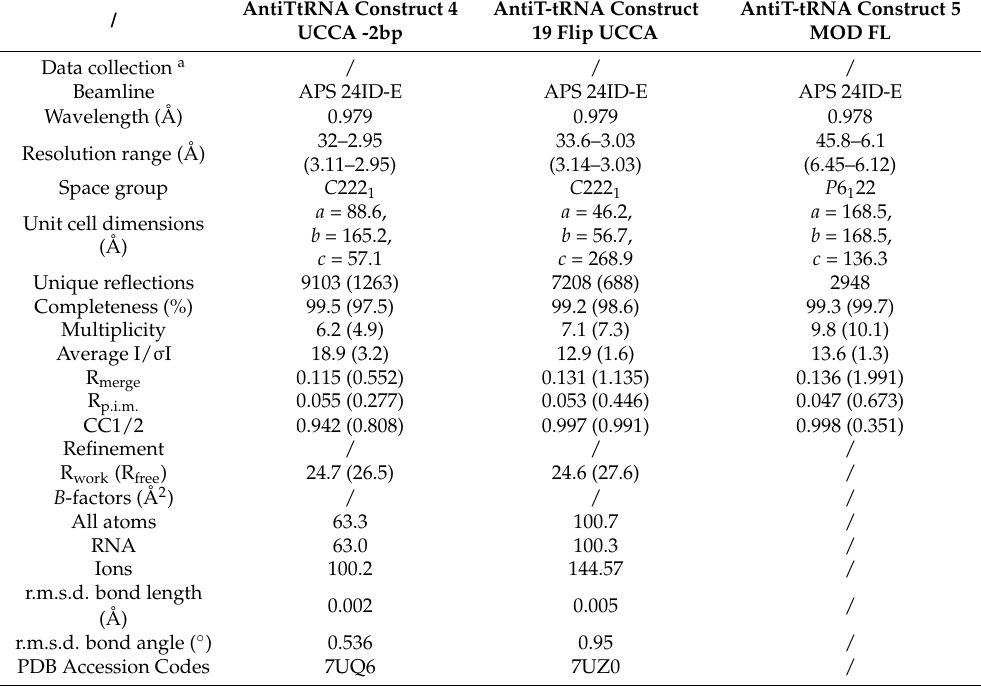
Table 1. X-ray data collection and processing